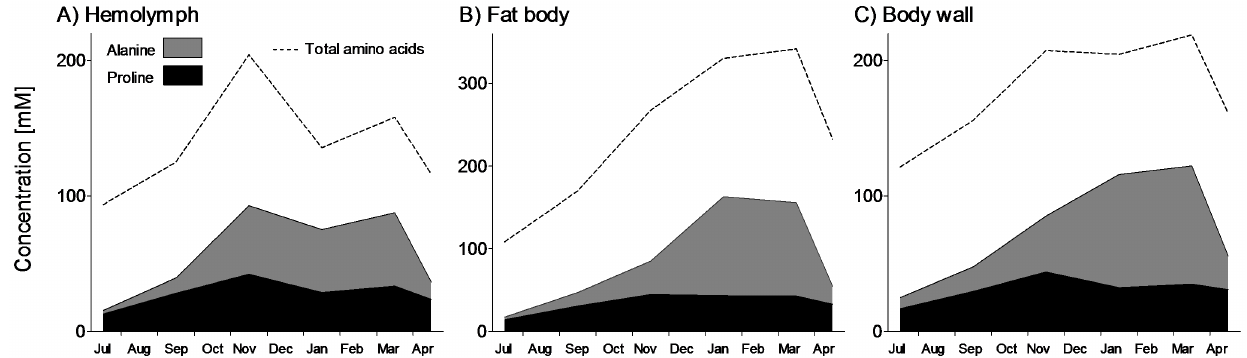
Figure 5. Free amino acids. Seasonal changes in concentrations of selected amino acids in hemolymph (A), fat body (B), and body wall (C) of field- sampled caterpillars of Cydia pomonella during 2010/2011. The areas showing concentrations of individual compounds are stacked and the total concentration of free amino acids is shown as a broken line. See Dataset S1 for details.